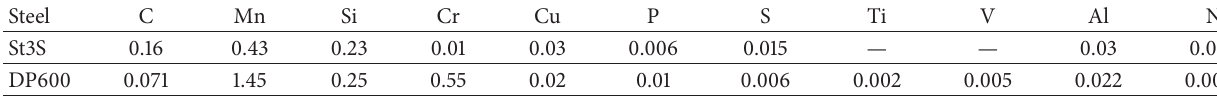
Table 3: Chemical composition of the investigated steels St3S and DP600, wt%.